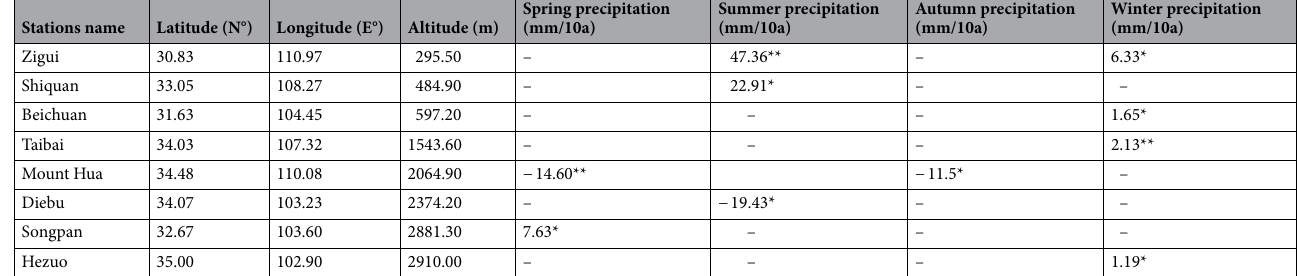
Table 3. Seasonal rate of change in mean precipitation (mm/10a) at weather stations with a significant trend in different seasons in the Qinling–Daba mountains during 1969–2018. * and ** indicate that the climate trends are significant at the 0.05 and 0.01 levels, respectively, based on the Mann–Kendall test for long-term